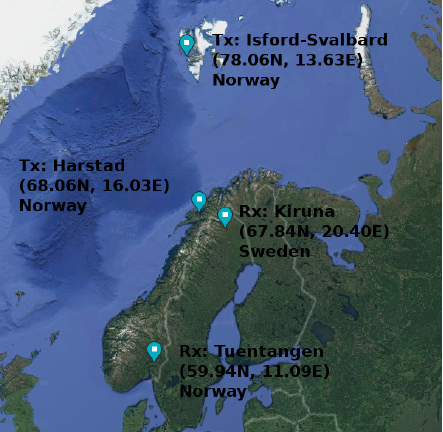
Figure 4. Deployment of the main sites used in the DAMSON project to sound the ionosphere. We can observe auroral, sub-auroral and polar